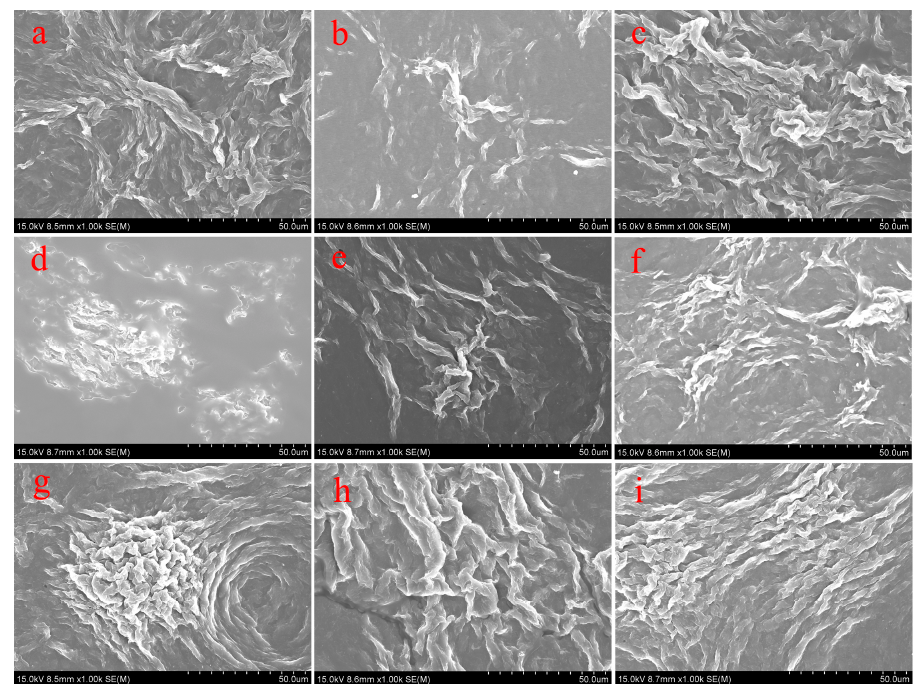
Figure 3. SEM images of TC16-Ben xerogels from gels in various solvents: ( a ) aniline; ( b ) petroleum ether; ( c ) n-hexane; ( d ) ethanol; ( e ) n-propanol; ( f ) isopropanol; ( g ) n-butanol; ( h ) n-pentanol; ( i ) isopentanol.